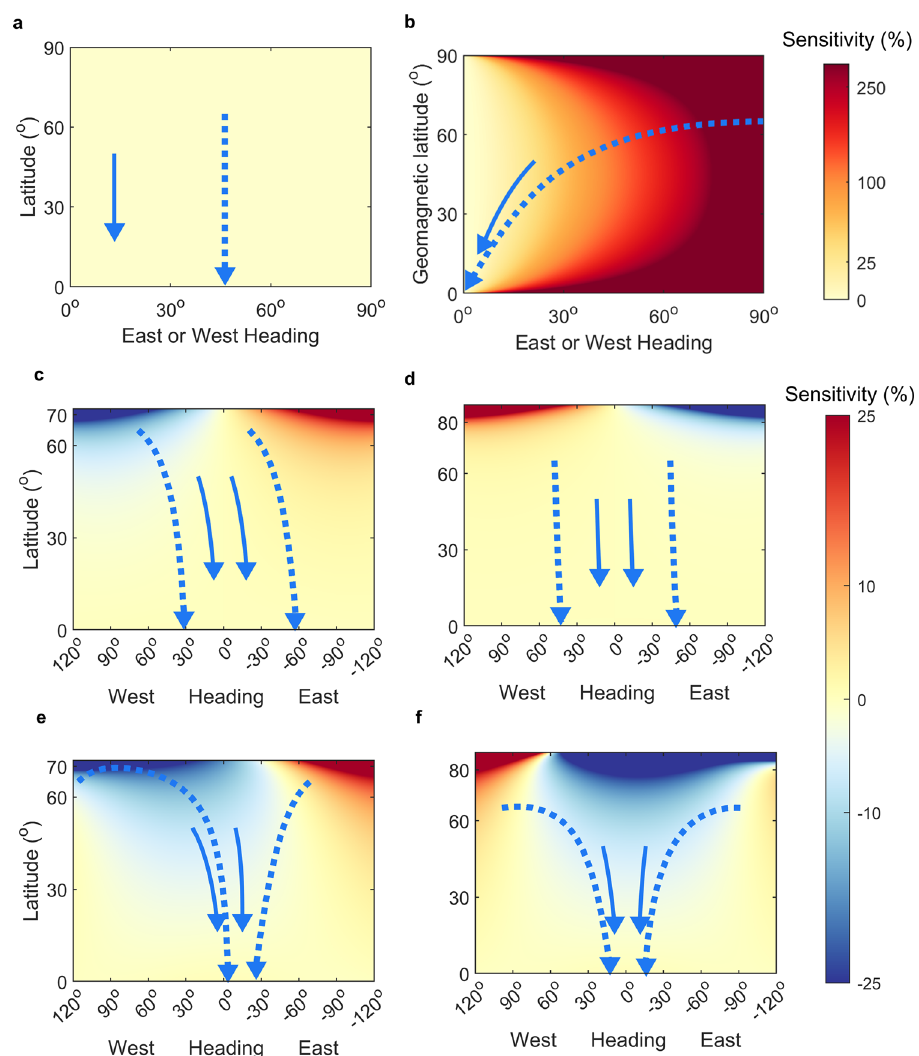
Fig. 3 Contrasting sensitivity in headings among compass courses. Sensitivity between fl ight-step headings, quanti fi ed as percentage growth of small errors between successive headings (colour scales on right), as a function of current heading (clockwise from South) and latitude (geomagnetic latitude for geomagnetic courses), for a constant-heading geographic loxodromes, or equivalently geomagnetic loxodromes in a geomagnetic dipole Earth, b magnetoclinic courses in a geomagnetic dipole, c fi xed sun compass courses on August 1 and d October 1, and e time-compensated sun compass (TCSC) courses on August 1 and f October 1. For positive (yellow to red coloured) values of sensitivity, expected errors in the successive headings will grow iteratively, whereas, for negative (white to blue coloured) values, expected headings are self-correcting. Blue arrows depict error-free headings for travel from (solid lines) 50°N – 15°N across 10° in longitude, and (dashed lines) 65°N – 0°N across 90° in longitude. For all simulations, fl ight-step distances were 360 km. In c – f , regions without sunset or sunrise (poleward of ~72° on August 1 and ~87° on October 1, respectively) are not